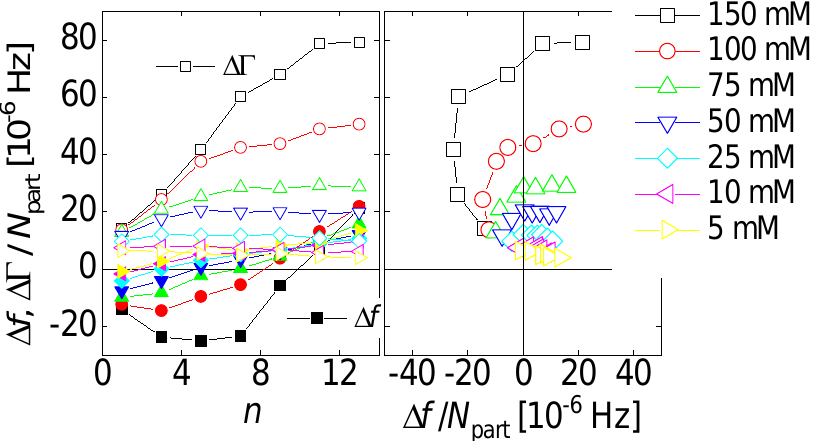
Figure 33. Shifts of frequency and bandwidth caused by the deposition of micron-sized silica spheres. The polar diagram on the right displays spirals, characteristic for the coupled resonance. The ion strength as indicated in the legend tunes the stiffness of the contact, where large ion strength leads to stiff contacts. Adapted from [167].